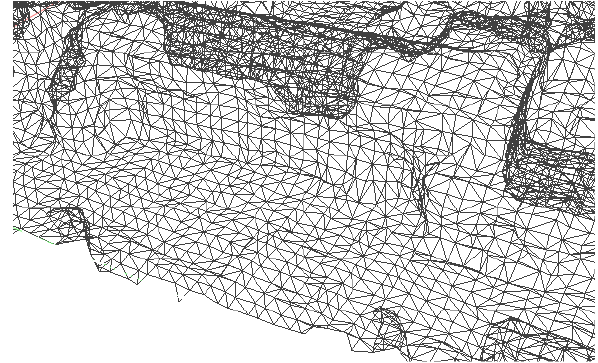
Figure 2. Wireframe view of a partial house and street in the test set. The generated uniformity of the mesh might affect the ability of MeshCNN to learn geometric representations